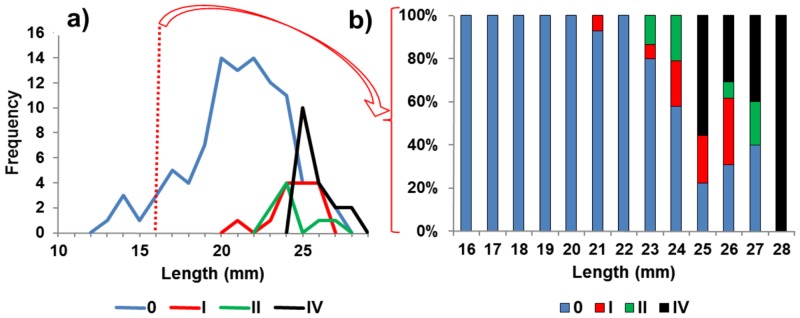
Female reproductive stages among length frequencies.a) 10–28 mm body length classes of stages F0, FI, FII and FIV from 2002, 2007, 2011, 2012 and 2013 combined with a vertical red line marking the greater than 16 mm size ranges included in; b) the percentages of reproductive stages F0, FI, FII and FIV among 16 mm and greater length females.